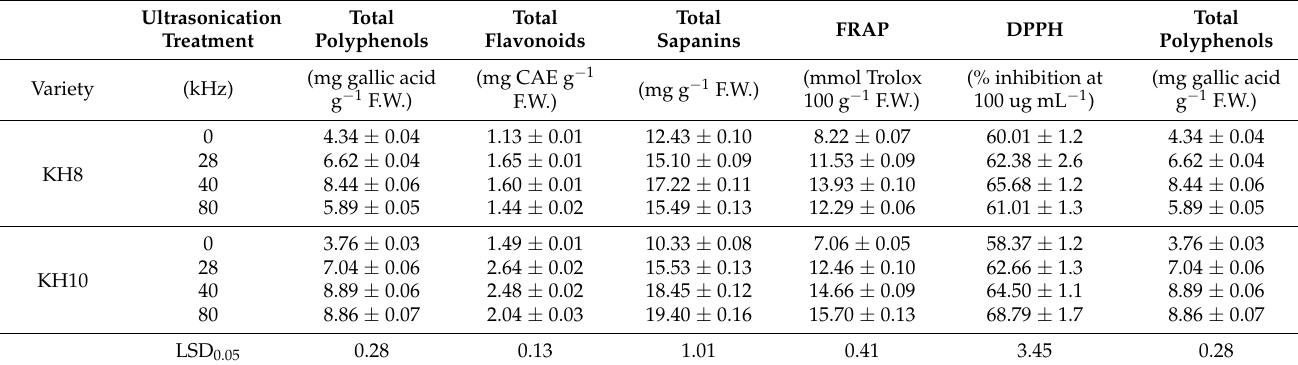
Total Polyphenols